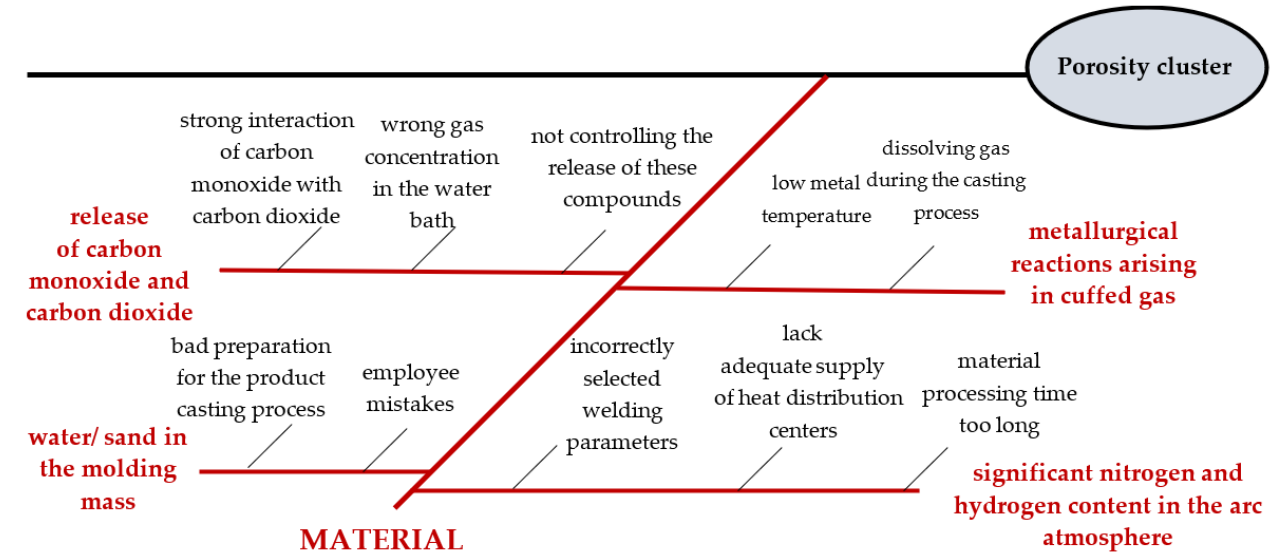
12 of 21 Figure 5. Ishikawa diagram for porosity cluster on mechanical seal.